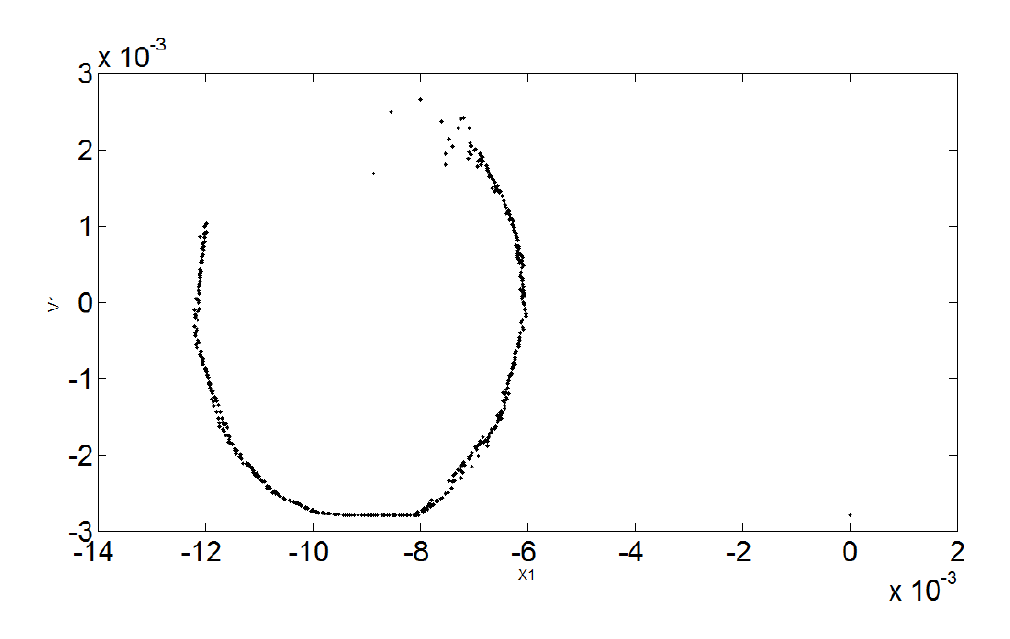
= − 0 . 002788 m ; ξ = 0 . 412; κ = 1 . dr